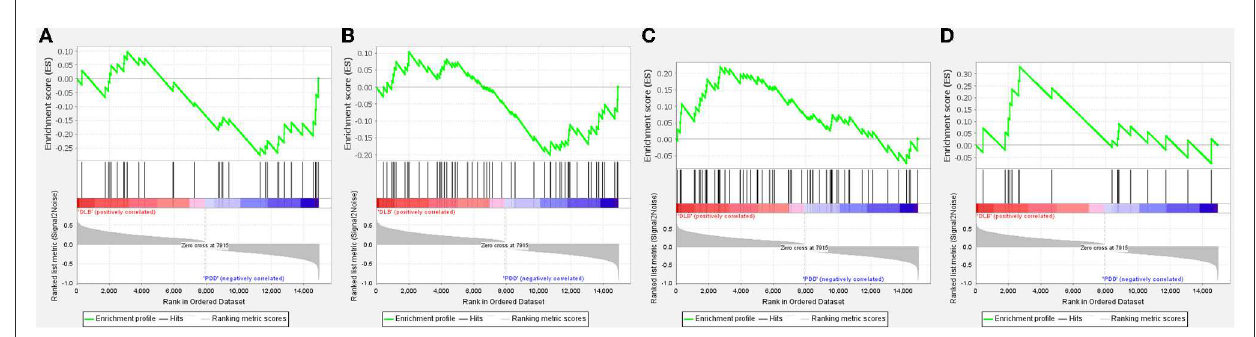
FIGURE3 Gene set enrichment analysis (GSEA) plots of the most enriched gene sets in the Parkinson’s disease dementia (PDD) and Dementia with Lewy bodies (DLB) groups. The enriched pathways positively correlated with PDD: (A) glycerolipid metabolism; (B) viral myocarditis. The enriched pathways positively correlated with DLB: (C) One carbon pool by folate; (D) B-cell receptor signaling